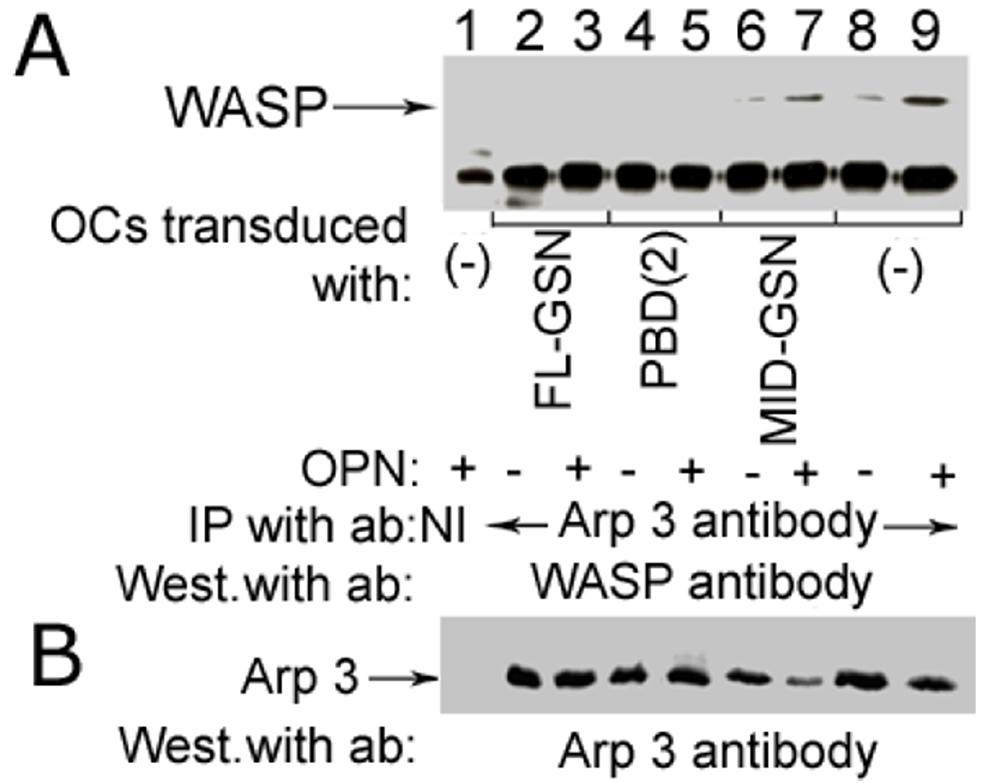
Figure 12 Transduction of PBD containing gelsolin peptides reduces the interaction of WASP with Arp3 protein Osteo- clasts were transduced with indicated TAT-proteins and treated with OPN (denoted as (+)) or PBS (denoted as (-)). Equal amount of lysates were immunoprecipitated with anti-Arp3 antibody (lanes 2–9) and non-immune serum (NI, lane 1). The immunoprecipitates were subjected to SDS-PAGE. Panel A. Western analysis with a WASP antibody. Arrow points to WASP protein. Panel B. Western analysis with an Arp3 antibody. The immunoblot shown in panel A was stripped and blotted with an Arp 3 antibody to detect the levels of Arp 3 in each immunoprecipitates. The results represent one of three experiments